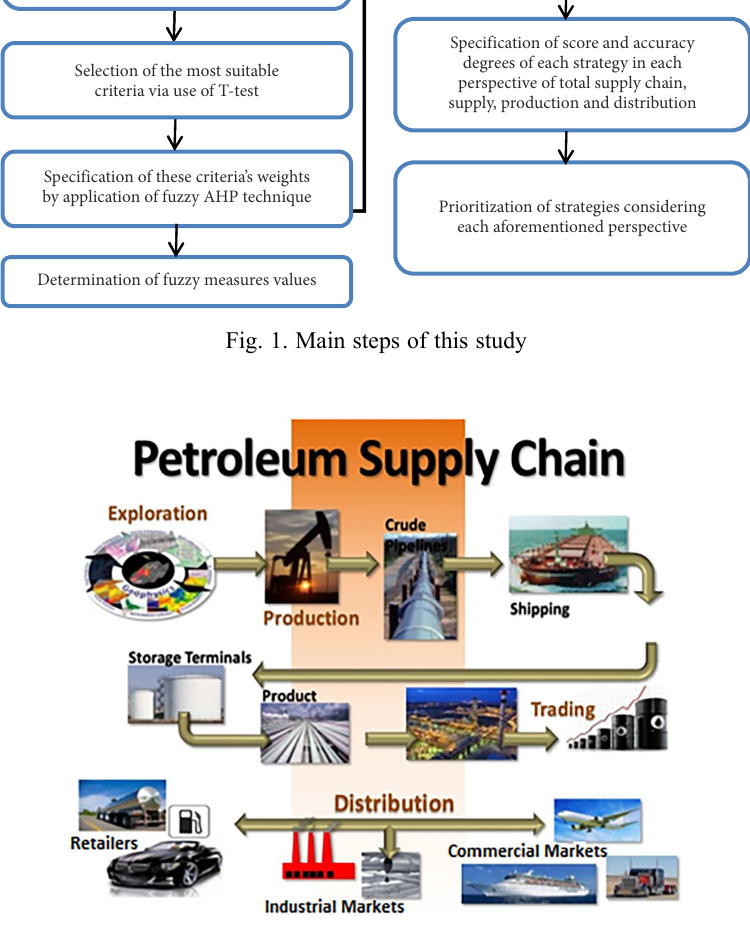
Fig. 2. Petroleum supply chain (WKP